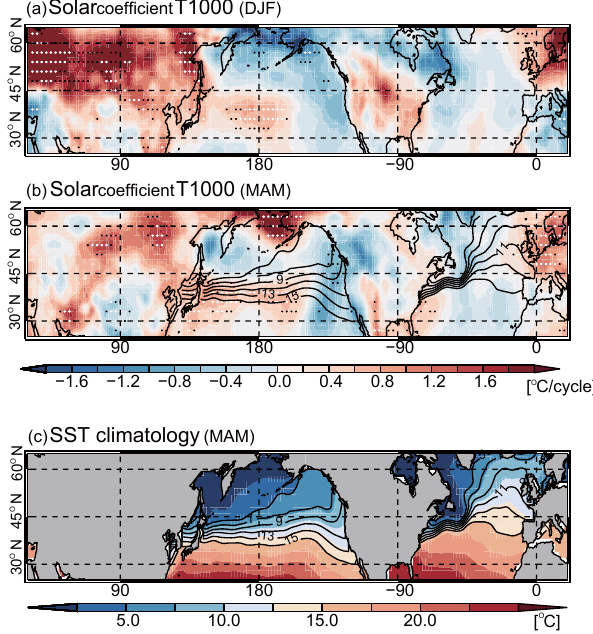
Figure 8. ( a and b ) Solar regression coefficient of the surface tem- perature (at 1000hPa) over the NH mid-latitudes for (a) DJF and (b) MAM. Isothermal lines over oceans in (b) represent climatolog- ical SSTs displayed in the bottom panel. (c) Climatological mean SST in spring (MAM). Stippled areas with black and white dots in- dicate statistical significance at the 90 and 95% level, respectively.